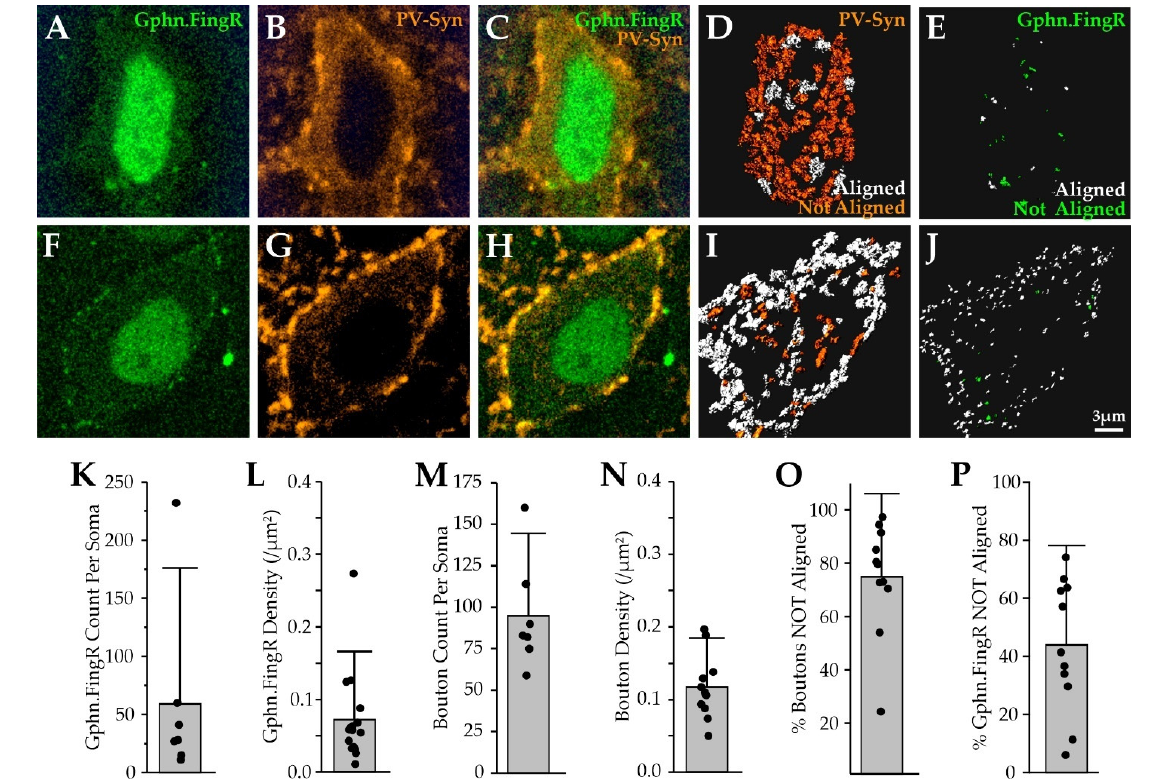
Figure 10. The majority of PV inputs onto PV neurons lack postsynaptic gephyrin. ( A ) optical section of a PV neuron soma showing Gephyrin.FingR (green) fluorescence; ( B ) PV-Syn fluorescence (orange) for the same cell in A showing cytoplasmic PV-Syn fluorescence; ( C ) Gephyrin.FingR and PV-Syn fluorescence overlaid; ( D ) PV bouton renderings for the cell’s entire soma, color-coded by Gephyrin.FingR alignment; ( E ) Gephyrin.FingR puncta renderings for the cell’s entire soma, color-coded by PV bouton alignments; ( F – J ) as in A – E , but for a different PV neuron; ( K – P ) quantitation of Gephyrin.FingR and PV boutons on PV somas; ( O ) percentage of PV boutons not aligned with postsynaptic Gephyrin.FingR; ( P ) percentage of Gephyrin.FingR puncta not aligned with presynaptic PV boutons.